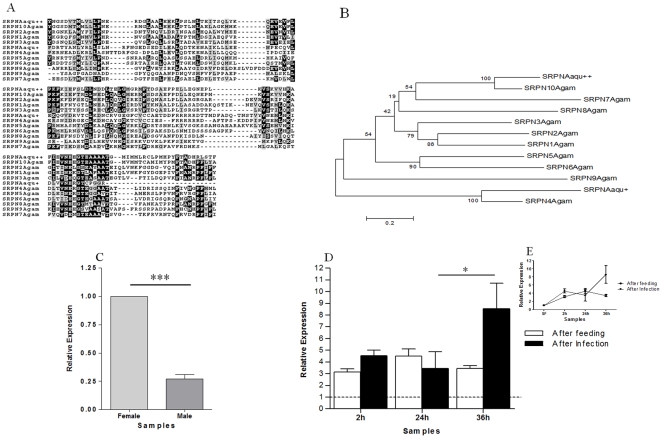
Characterization of serpin induction in mosquitoes fed on sugar, blood, or infected blood.A: Multiple aminoacid sequence alignment of A. aquasalis and A. gambiae serpin sequences. B: Phylogenetic tree constructed using neighbor-joining method. C–E: Expression levels of serpin determined by RTPCR following various feeding regimens. C: Sugar-fed males and females, D and E: sugar-fed (dotted line and SF), blood-fed (AF) and P. vivax infected (AI) females. A: Multiple aminoacid sequence alignment of A. aquasalis and A. gambiae serpin sequences. B: Phylogenetic tree was performed using neighbor-joining method. C - E: Relative expression of serpin in sugar-fed males and females (C); sugar-fed (dotted line), blood-fed and P. vivax infected females (D - E). h–hours. Accession numbers of serpin (SRPN) sequences from: A. gambiae (Agam) (SRPN1–AGAP006909-PA, SRPN2–AGAP006911-PA, SRPN3 - AGAP006910-PA, SRPN4–AGA009679-PA, SRPN5–AGAP009221-PA, SRPN6–AGA009212-PA, SRPN7AGAP007693-PA, SRPN8–AGAP003194-PA, SRPN9–AGAP003139-PA, and SRPN10–AJ420785). + Sequence of serpin found in the 2hAF-I library (GR486572). ++ A. aquasalis serpin sequence from GenBank, accession number EX809758. +−: s.e.m.; * p<0.05, ** 0.03>p>0.01, *** p<0.01.